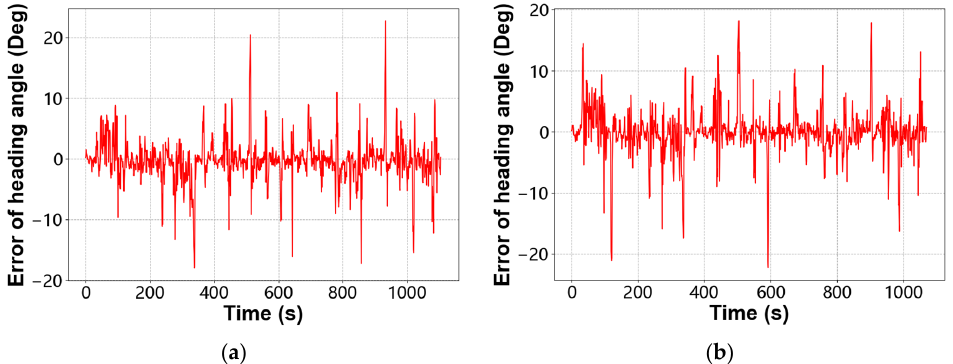
Figure 8. Heading angle error after correction. ( a ) Smartphone Huawei P30; ( b ) Smartphone Huawei P40.